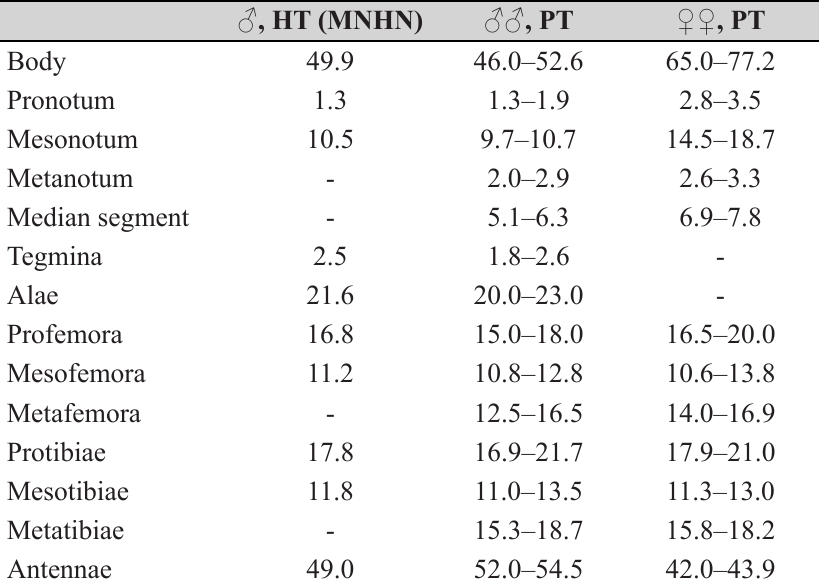
Table 7 . Measurements of Phantasca nigrolineata sp. nov. (in mm). HT = Holotype; PT =